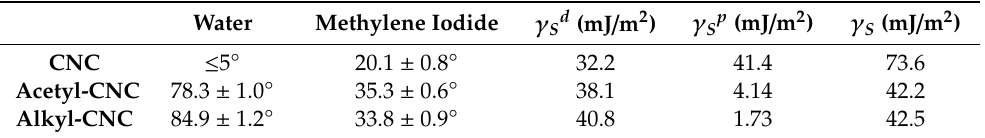
Table 2. Contact angle, γ Sd (dispersion component), γ Sp (polar component), and γ S (total surface energy) values of CNCs and modified